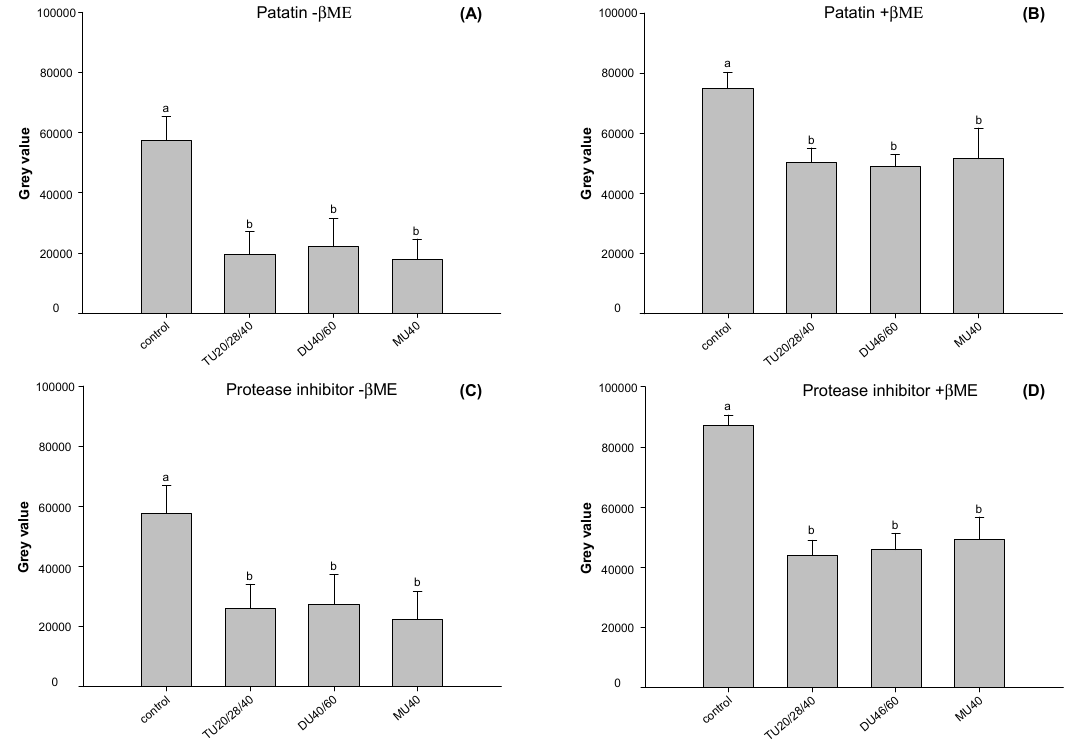
Figure 6. The band intensity of patatin ( A , B ) and protease inhibitor ( C , D ) of potato protein in reducing (+ β ME) and non-reducing (– β ME) SDS-PAGE. Means with different letters (a–b) differ significantly ( p < 0.05).